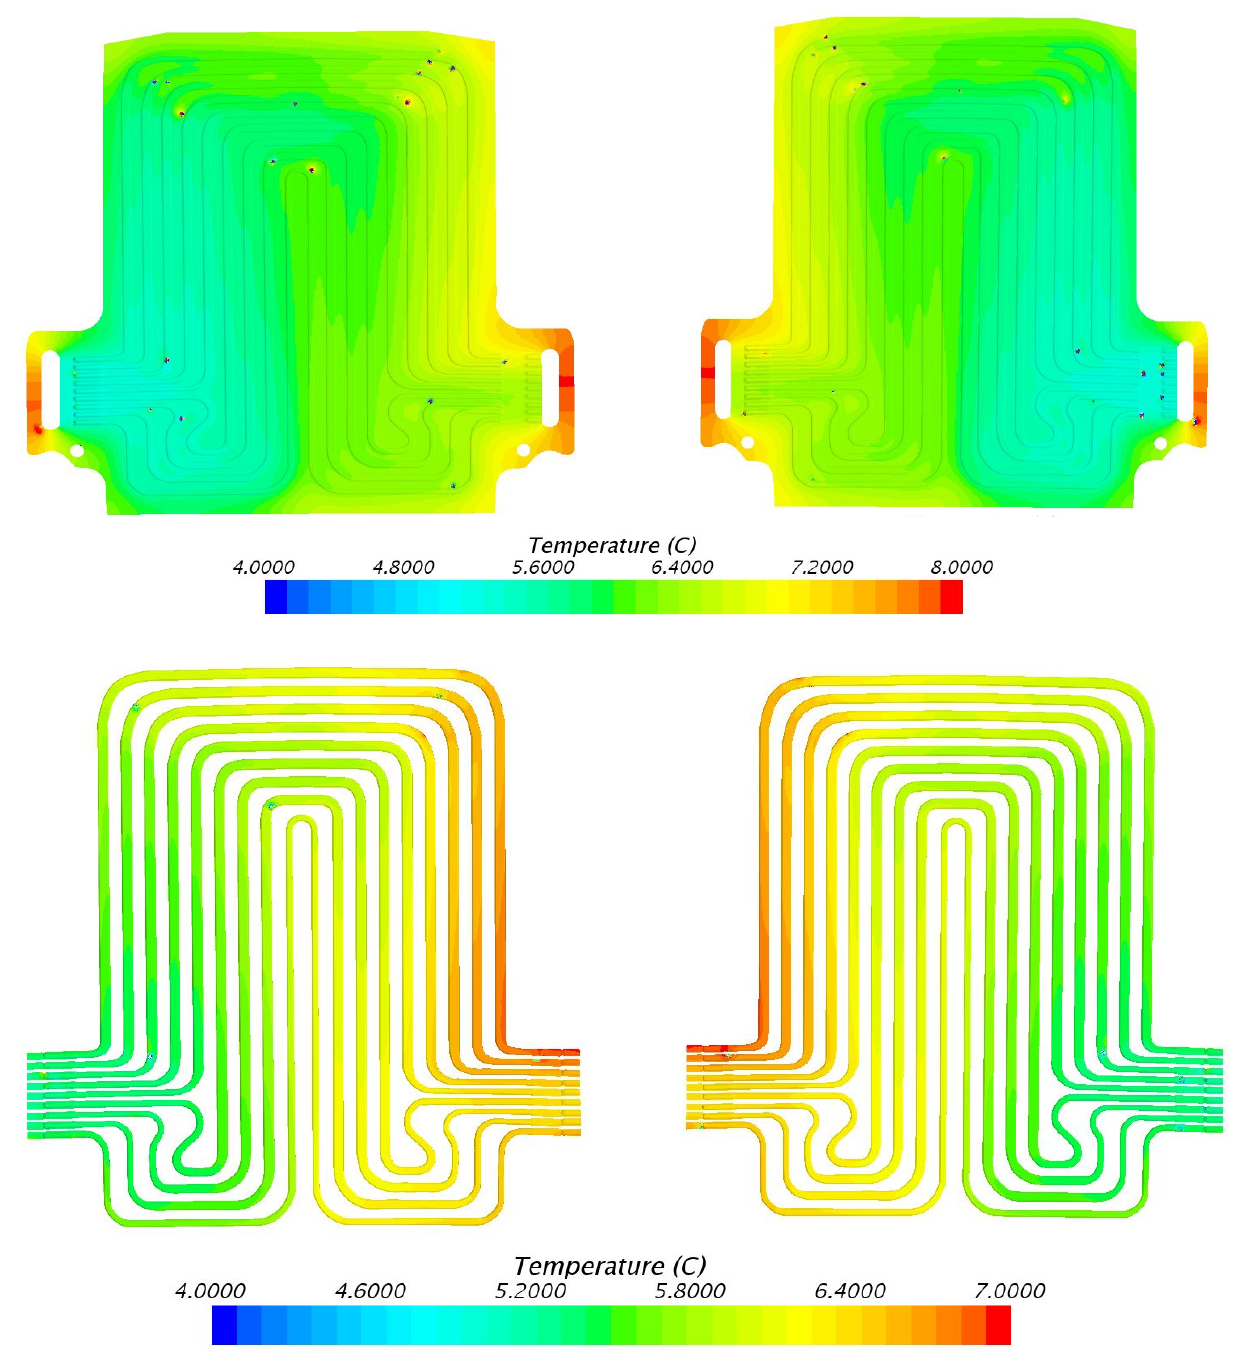
Figure 7. Temperature field at 20 A discharge current and 5 °C coolant inlet temperature with heat flux at position 1 = 575.5 W/m 2 , position 2 = 599.3 W/m 2 , and position 3 = 149.4 W/m 2 .